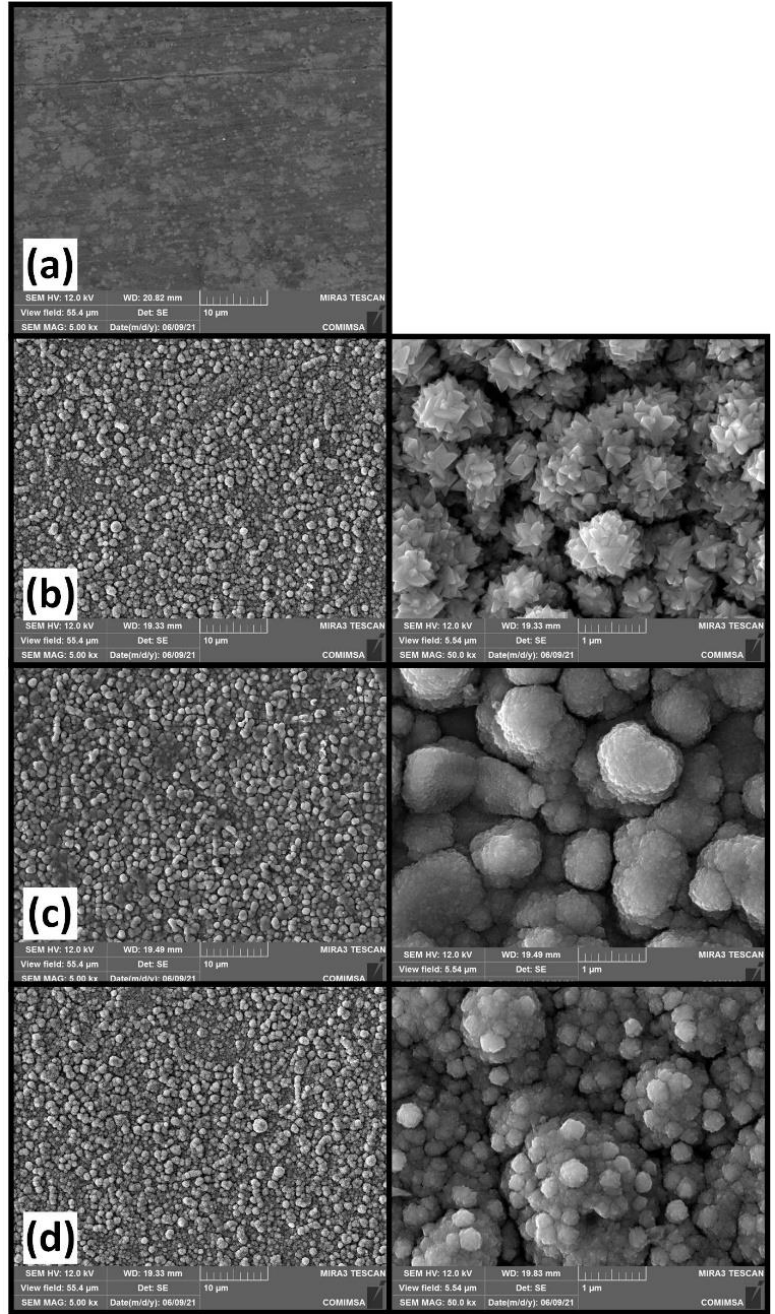
Figure 4. SEM micrographs of ( a ) base sample and ( b ) CPN and duplex-treated samples with substrate temperature for TiN deposition at ( c ) 400°C and ( d ) 450 °C.